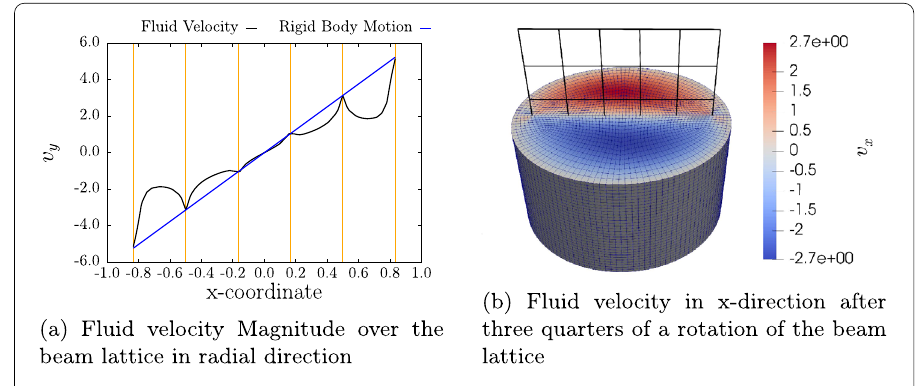
Fig. 13 Fluid velocity profile induced by the moving beam